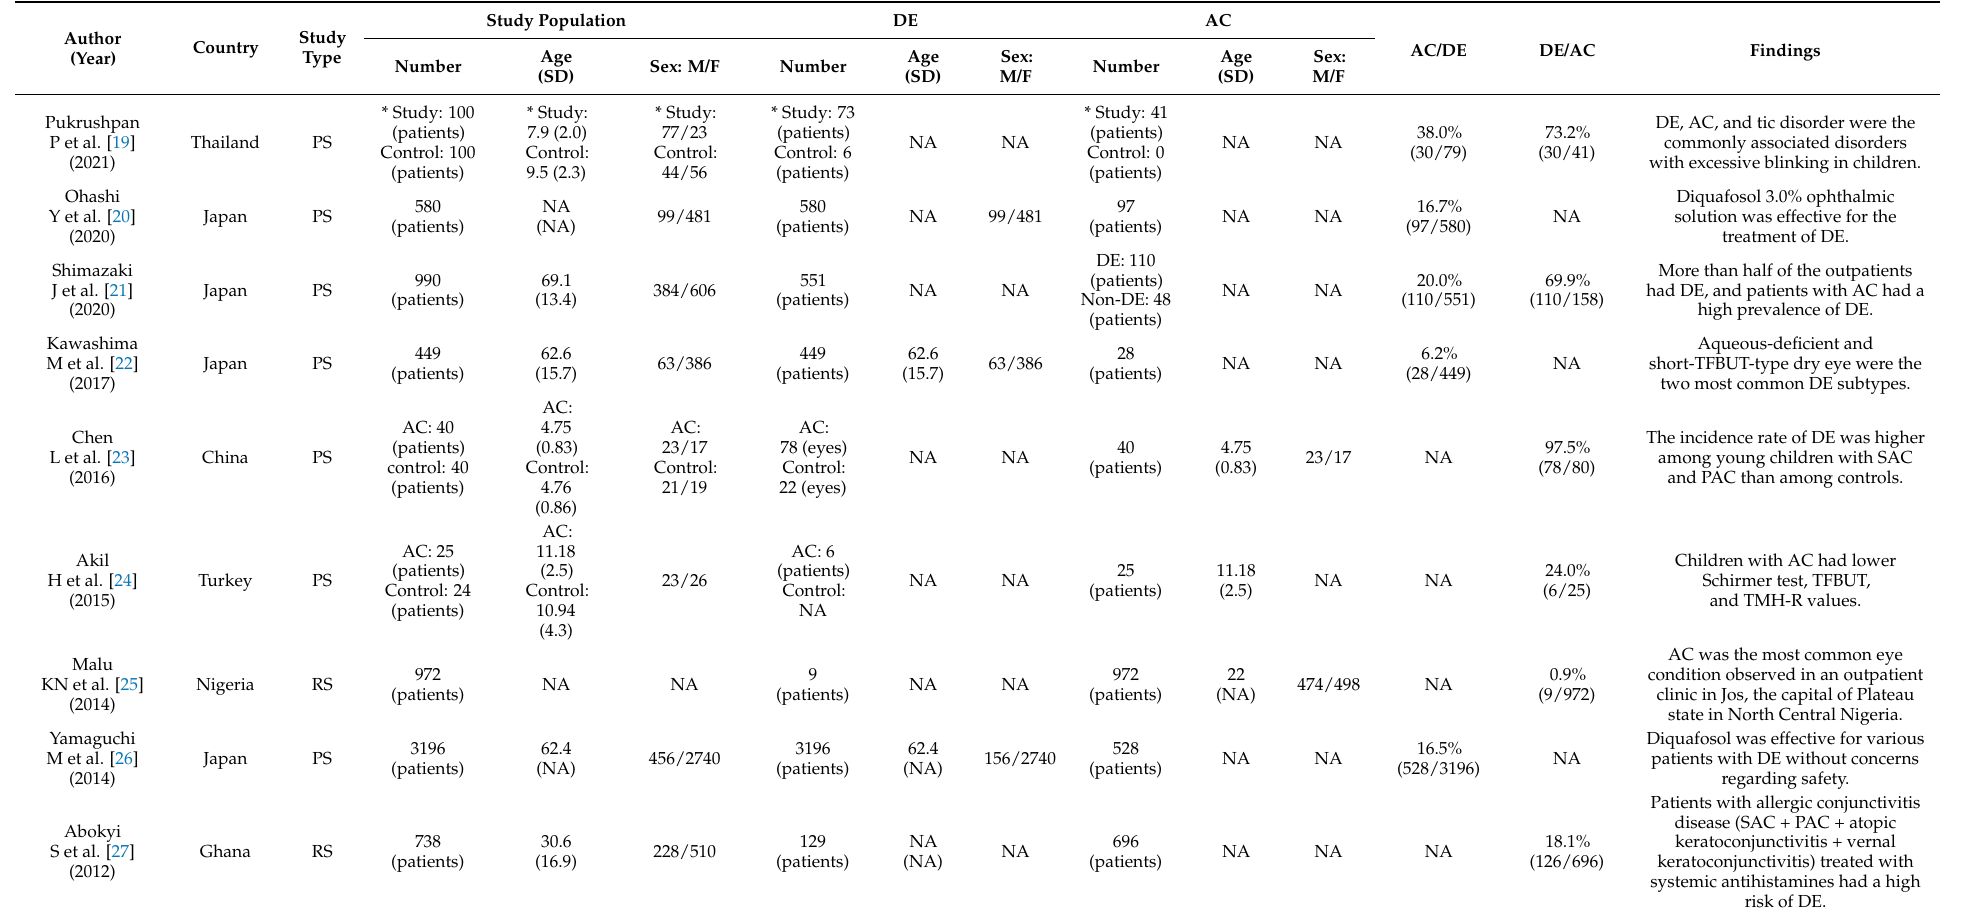
Table 2. Results of systematic reviews on the association between dry eye and allergic